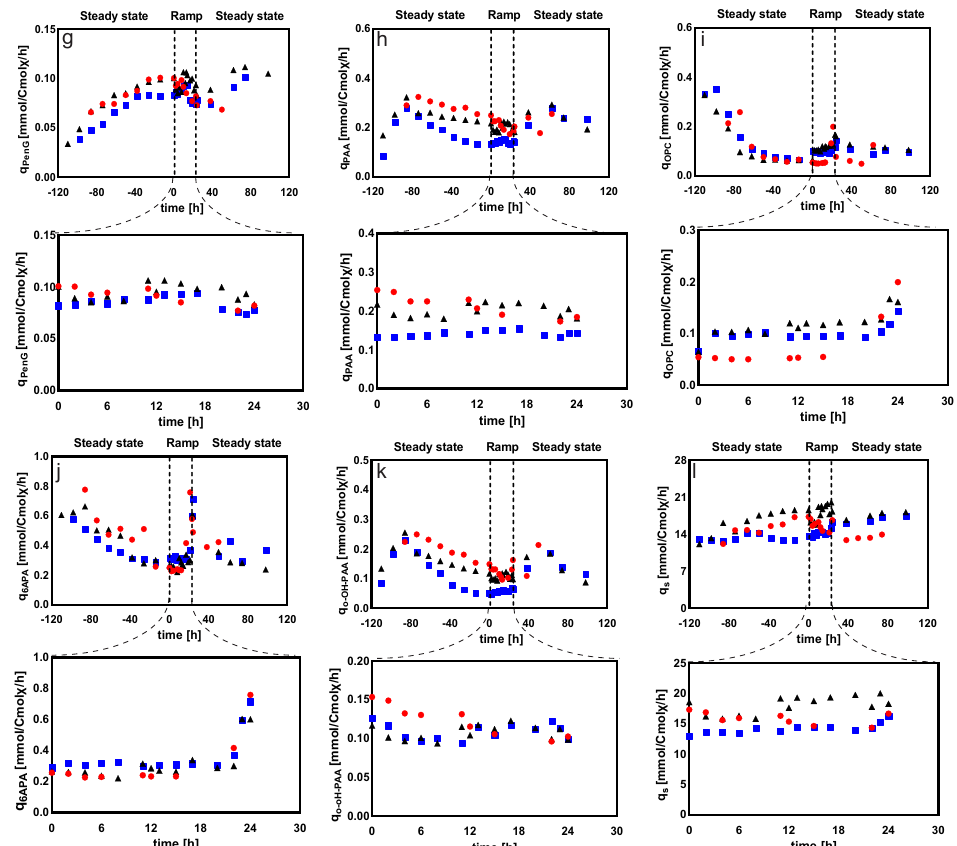
Figure 10. Measured concentrations of ( a ) Penicillin G (PenG), ( b ) 6-oxopiperidine-2-carboxylic acid (OPC), ( c ) 6-aminopenicillanic acid (6APA), ( d ) phenylacetic acid (PAA), ( e ) ortho-hydroxyphenyl acetic acid (o-OH-PAA), ( f ) biomass (C X ), ( g ) the biomass-specific penicillin production rate (q ), PenG ( h ) the biomass-specific phenylacetic acid consumption rate (q ), ( i ) the biomass-specific 6- PAA oxopiperidine-2-carboxylic acid production rate (q ), ( j ) the biomass-specific 6-aminopenicillanic OPC acid production rate (q ), ( k ) the biomass-specific o-OH-PAA production rate (q ) and 6APA o − OH − PAA ( l ) the biomass-specific substrate consumption rate (q ) during DO-ramp experiments with Penicillium s chrysogenum Wisconsin 54-1255. DO: steady state phases ( − 120–0 h, 60%), ramp-down phases (0–24 h, linearly decreased from 60% to 0%), and DO recovery phases (24–120 h, shifted up to 60%). Three legends represent three replicate